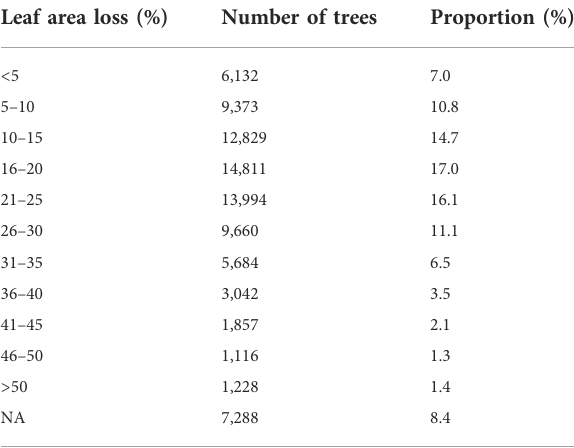
TABLE 3 Frequency distribution for potential leaf area loss based on the inventory data.